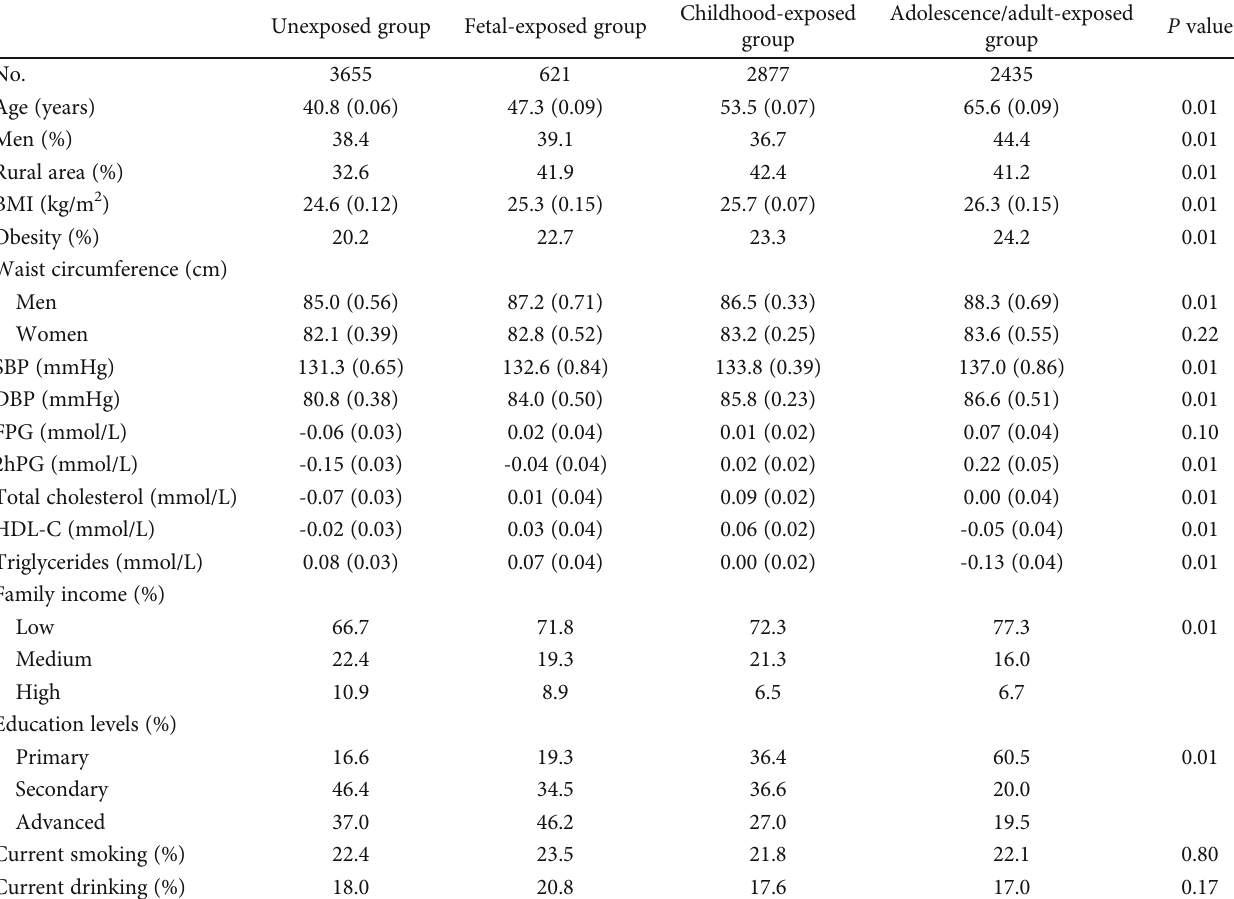
Table 2: Baseline characteristics of study population according to Chinese famine exposure between 1959 and